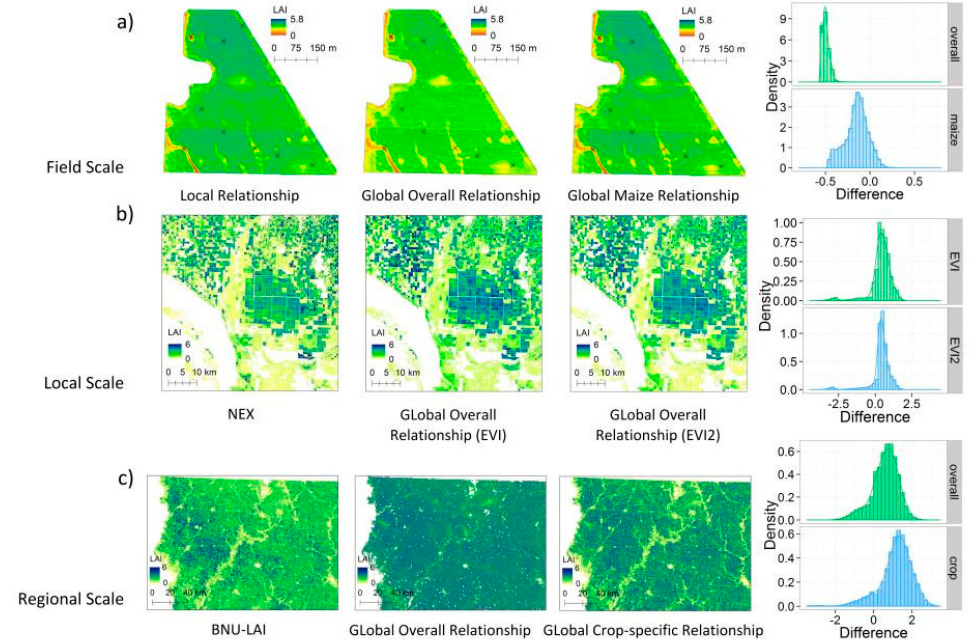
Figure 10. LAI maps generated using the global and local LAI-VI relationships for three example applications. In each row, the leftmost map is the reference LAI data set. The second and third maps were produced based on global LAI-VI relationships. Any LAI value greater than 6 m 2 /m 2 is excluded from this analysis to avoid extrapolation. The fourth figure in each column shows the histograms of the difference between LAI maps based on global LAI-VI relationship and the reference map (estimated LAI minus reference LAI). Row ( a ): Results of the field scale validation in Wisconsin based on LAI-EVI relationships. The cross symbols indicate the location of LAI measurement points in the field. Row ( b ): Local scale validation in California. The maps only show a window of the footprint to highlight spatial details. The histogram of image difference was produced from a random sample of 100,000 points placed on the entire Landsat footprint. Row ( c ): Regional scale validation results in Iowa using LAI-EVI relationships. Both the reference and the map produced from this work used 16-day composite MODIS product centered on 12 July 2009.